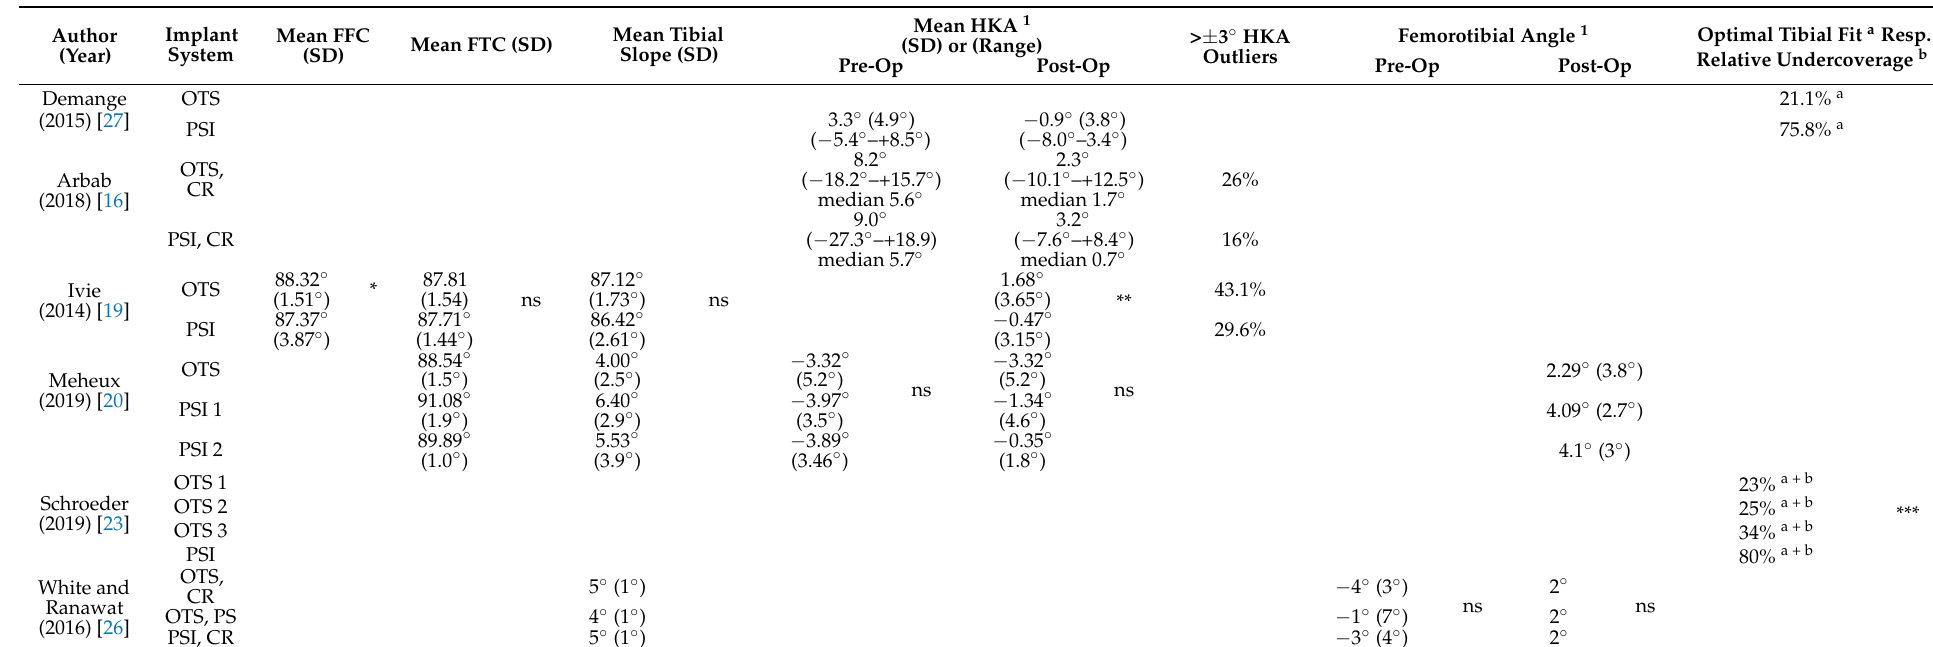
Table 4. Radiological